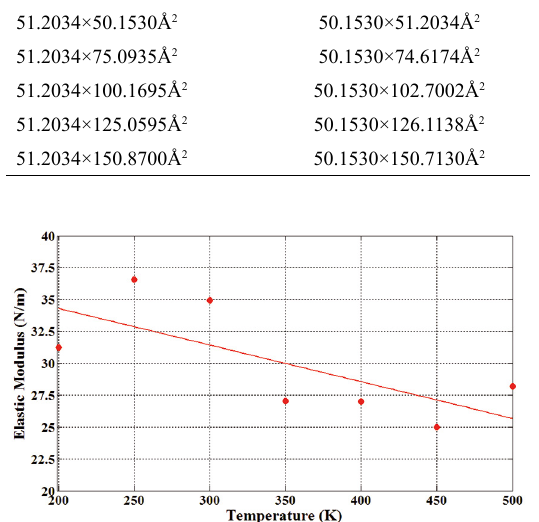
Figure 11: Effect of temperature on the elastic modulus of the grapheneylene for a 40×60 Å 2 armchair